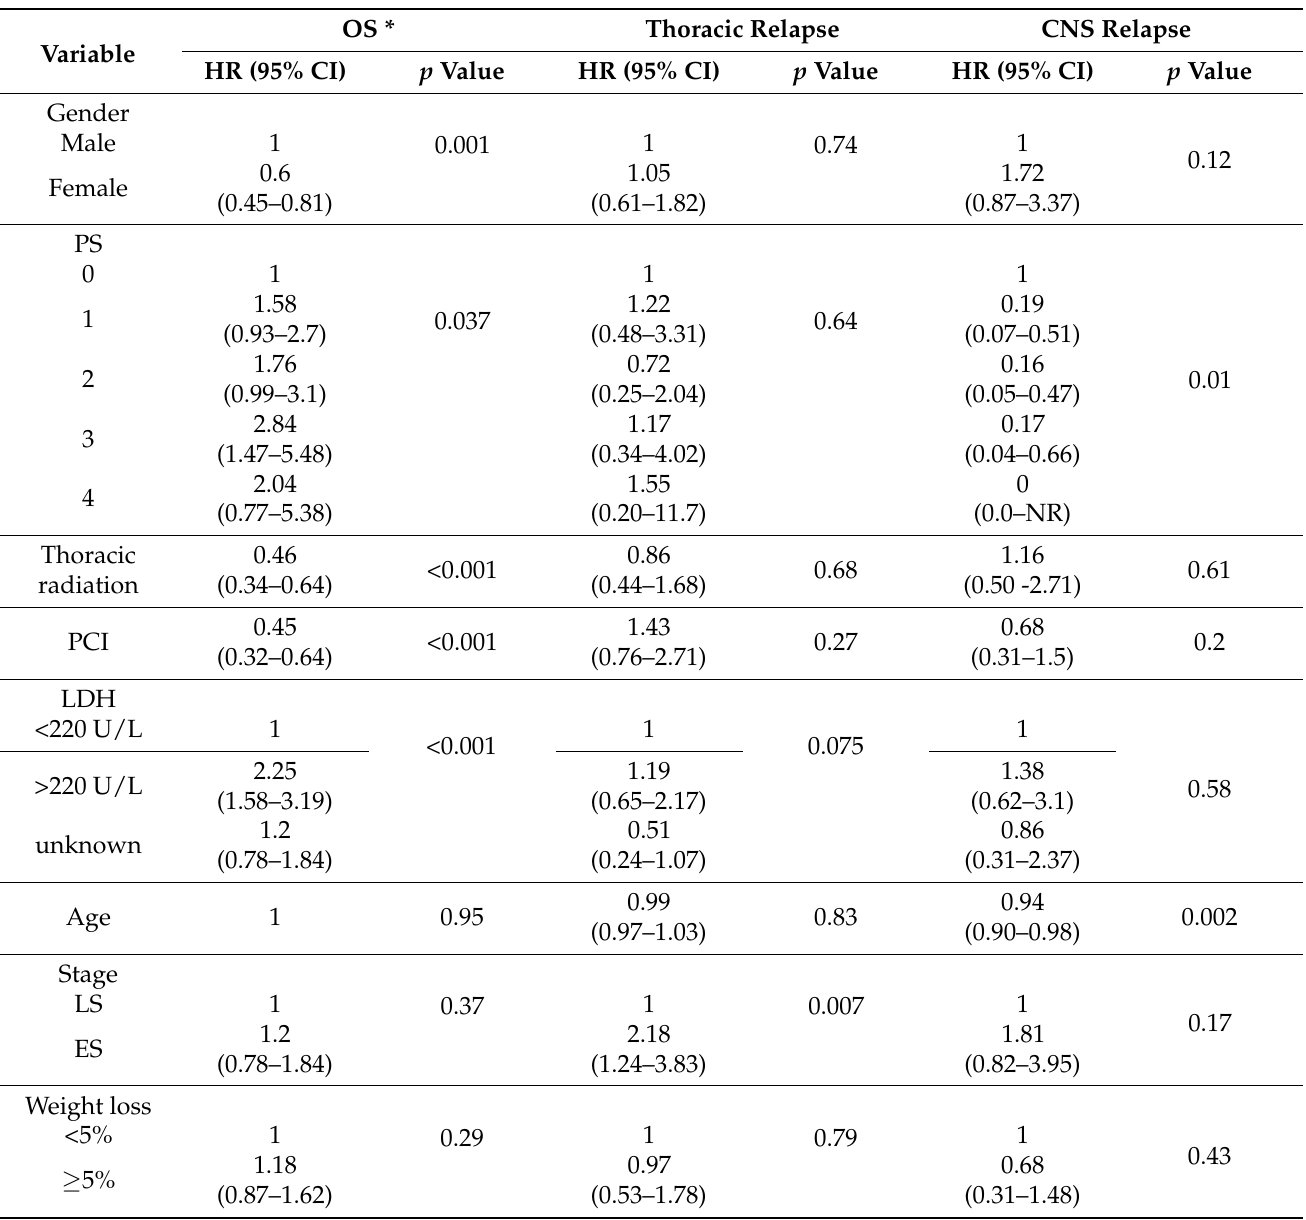
Table 3. Results of multivariate